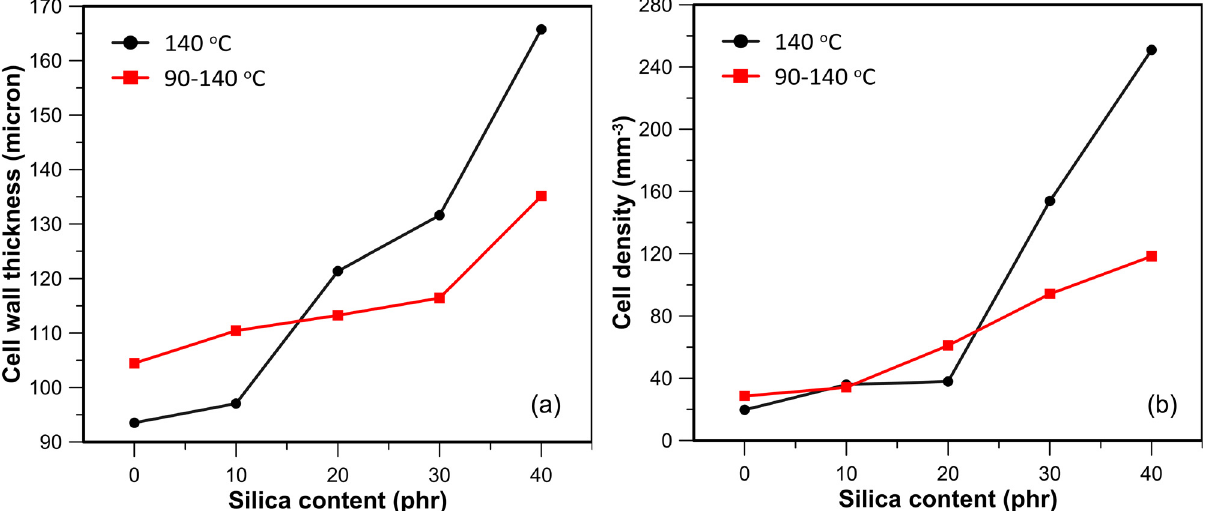
Figure 8: Variation of ( a ) cell wall thickness and ( b ) cell density of NR